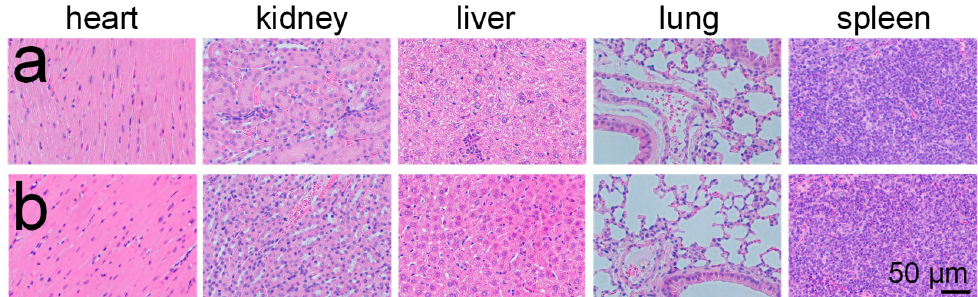
Figure 5. Combination of oral administration of DSF and intravenous administration of PEG-MS- Cu nanospheres showed no obvious toxicity to normal tissues in vivo. Histological sections of heart, kidney, liver, lung, and spleen of mice without any treatment ( a ), and with combined oral administration of DSF and intravenous administration of PEG-MS-Cu nanospheres ( b